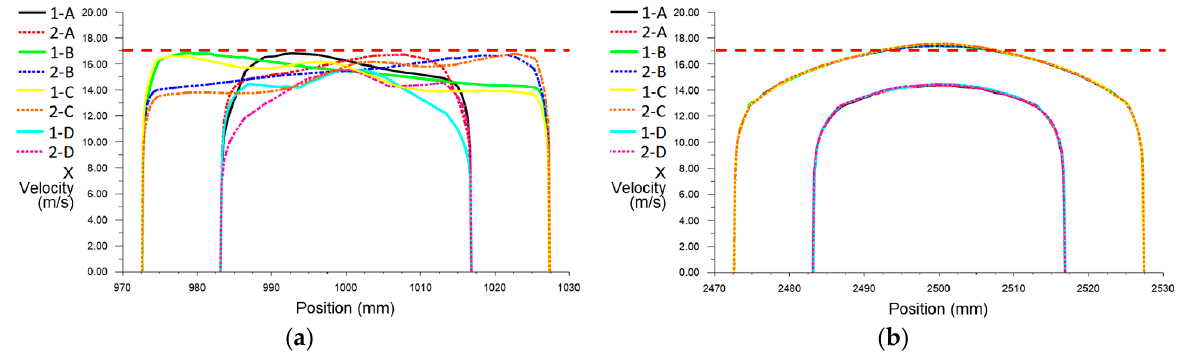
Figure 15. Velocity distribution on individual paths without FC. ( a ) 10D; ( b ) 25D.